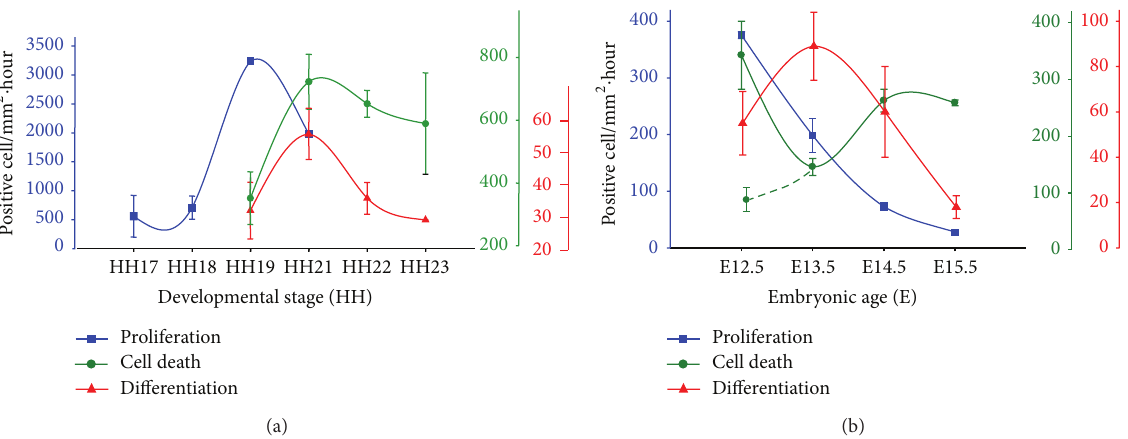
Figure 3: Relative magnitudes of cell proliferation, differentiation, and death in embryonic chick and mouse retinas. The results of the experiments described in Figures 1 and 2 were normalized per retinal surface area and hour, as explained in Section 3.2. Graphs represent the relative magnitude of cell proliferation (blue lines: BrdU-positive cells), differentiation (red lines: Islet1/2-positive cells), and death (green lines: TUNEL-positive cells) in chick (a) and mouse (b) embryonic retinas. The alternative slashed line representing cell death in the mouse retina indicates the magnitude of this process after subtracting the TUNEL-positive nuclei associated to the optic fissure, which plays a role in morphogenesis.